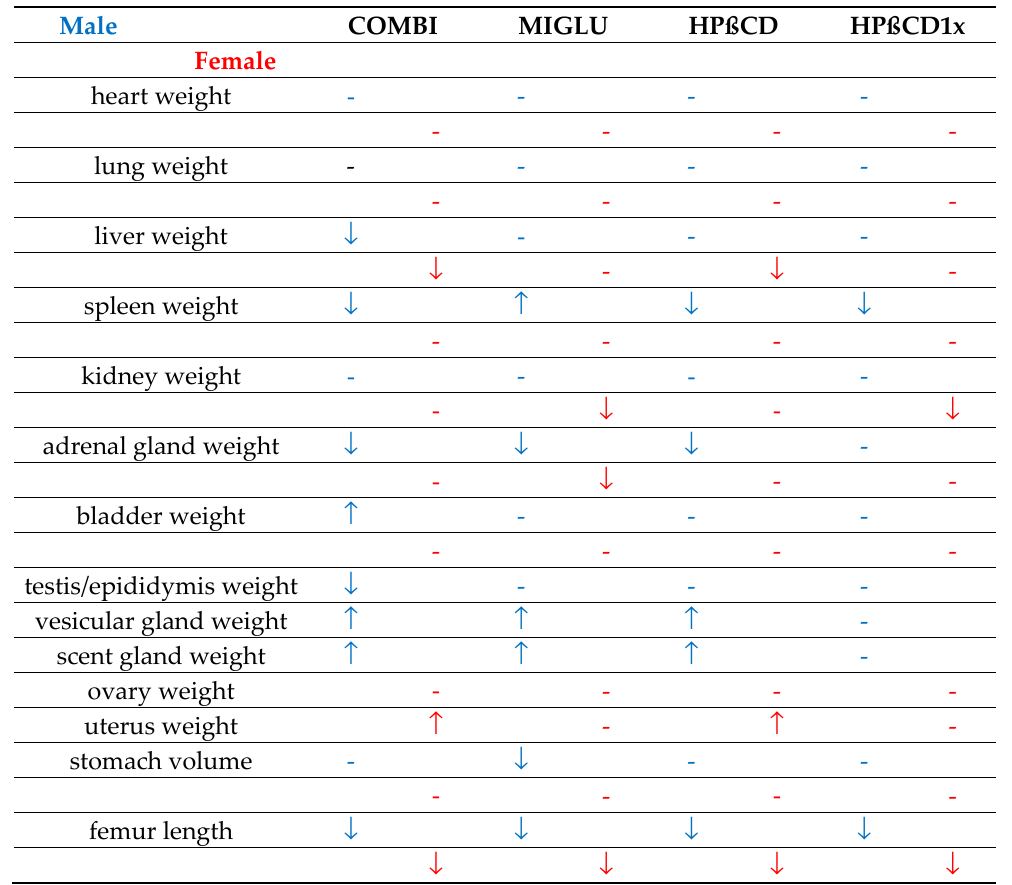
Figure 21. Changes of the relative organ weights, volumes, or lengths, induced by COMBI, MIGLU, HPßCD, and HPßCD1x in male and female Npc1 − / − mice. Significant increase ( ↑ ), decrease ( ↓ ) or no significant change (-) compared with the respective None groups.